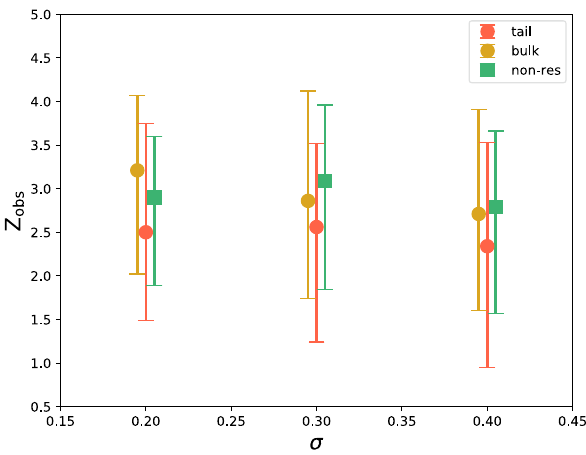
Fig. 14 Observed significance at varying kernel